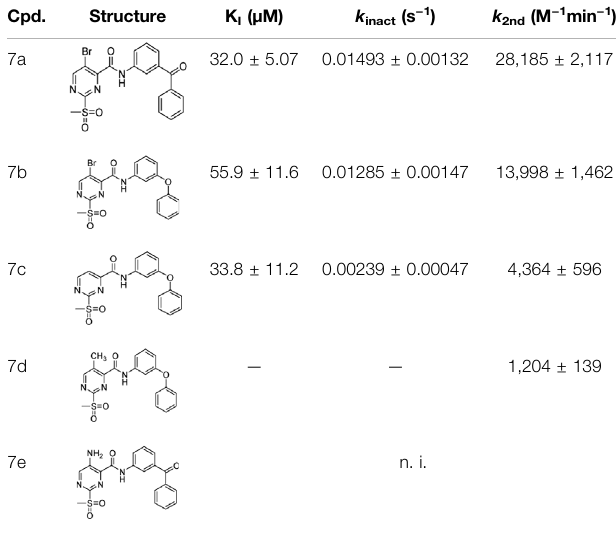
TABLE 3 | Inhibition constants (K I , k inact , k 2nd ) of the compounds 7a – e for S. aureus SrtA; n. i. (cid:1) < 20% inhibition at 100 µM.